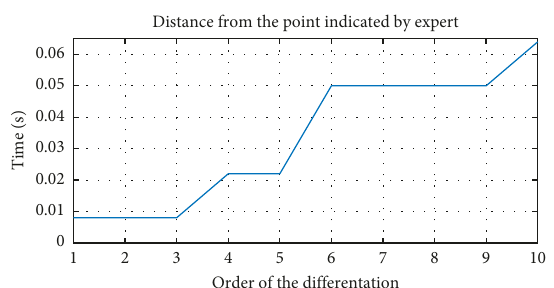
Figure 6: The differentiation δ 1 , 2 , ... , 10.